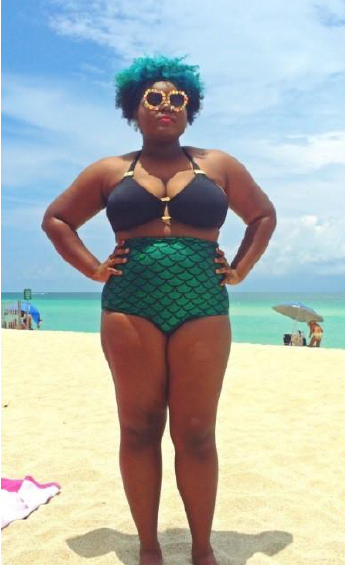
Figure 4. NOT FOR PORN, BBW, FETISH OR WHATEVER BLOGS. I don’t care what nomenclature you have for your blog. If you post a lot of explicit content, don’t reblog me. I think I’ve made myself clear. #fatmermaid #fatkini #fatspo #mermaiding #effyourbeautystandards #honormycurves #plussize #alternative #bluehair #naturalhair #fatshion #blackmermaid #POC #WOC #pinup #africanamericanmermaid (permission granted for reproduction).